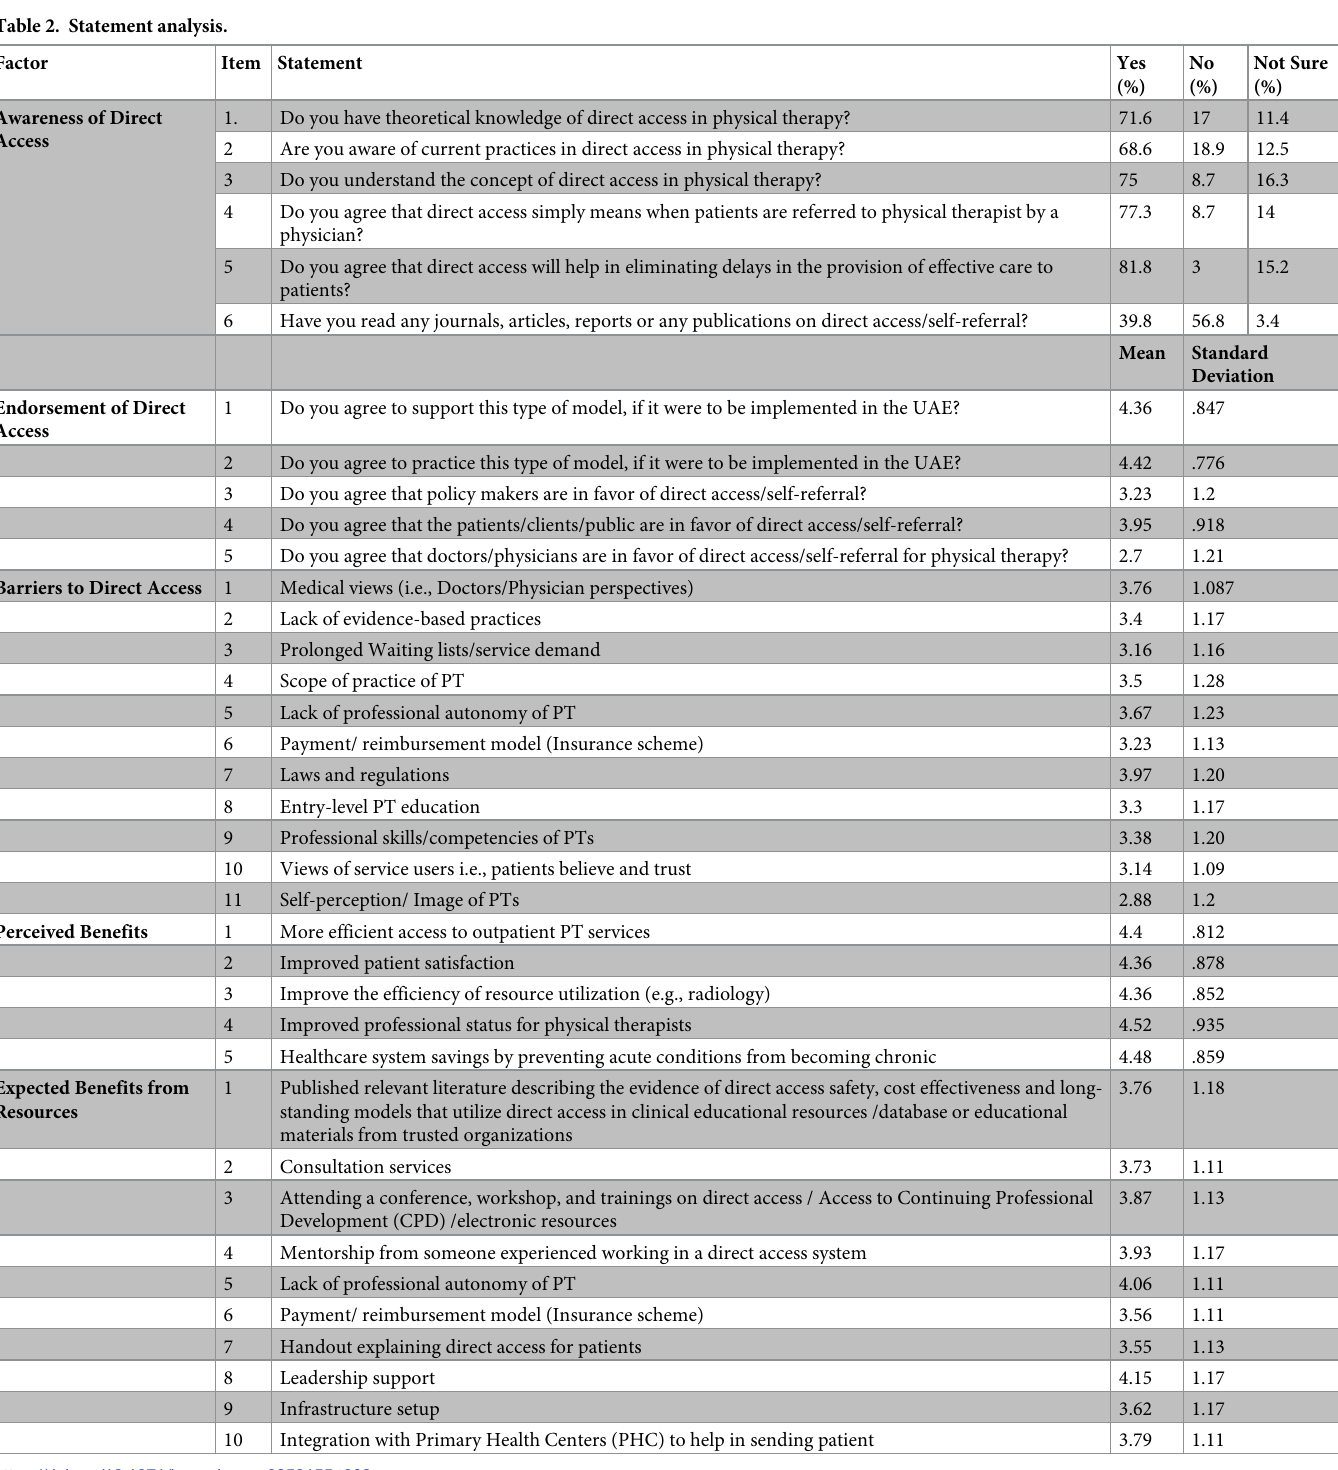
Table 2. Statement